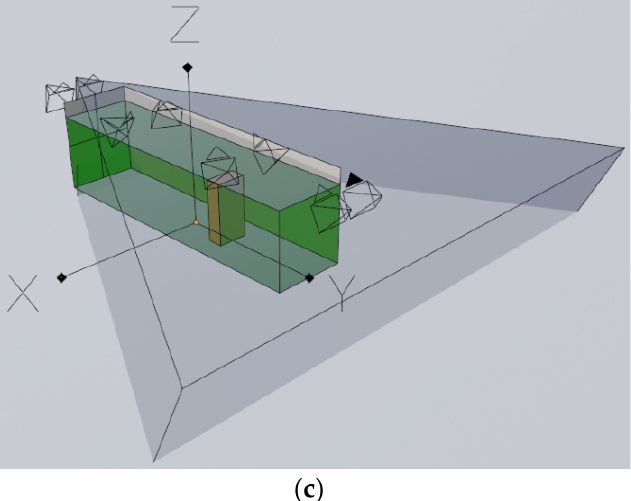
Figure A1. Simulated camera layouts: ( a ) four-camera corner, ( b ) four-camera arc, ( c ) eight-camera perimeter.